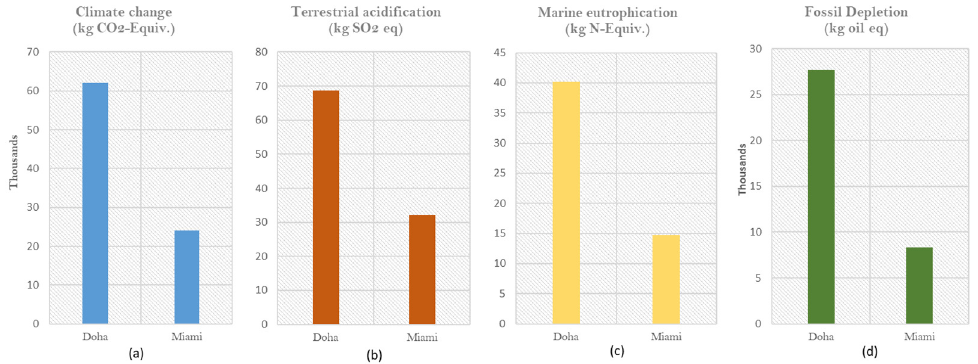
Figure 8. Impact assessment results for two case study buildings.